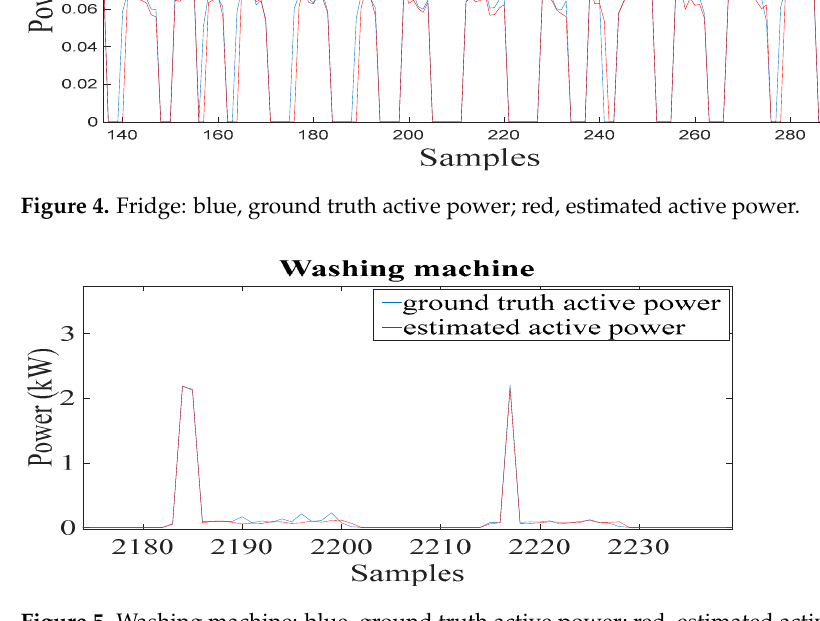
Figure 5. Washing machine: blue, ground truth active power; red, estimated active power.